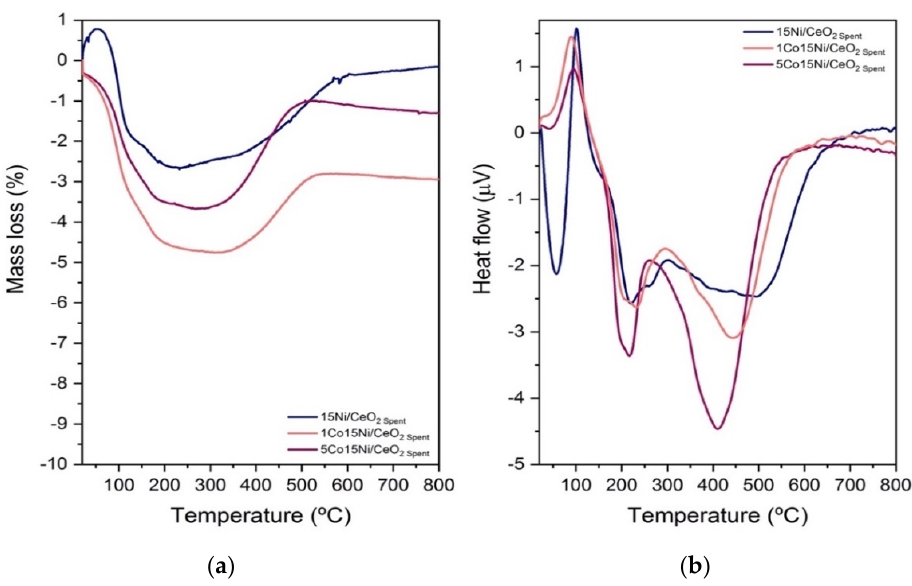
Figure 7. TGA analysis with O 2 for ( a ) Mass loss and ( b ) Heat loss of Co-Ni/CeO 2 catalyst with different Co content.